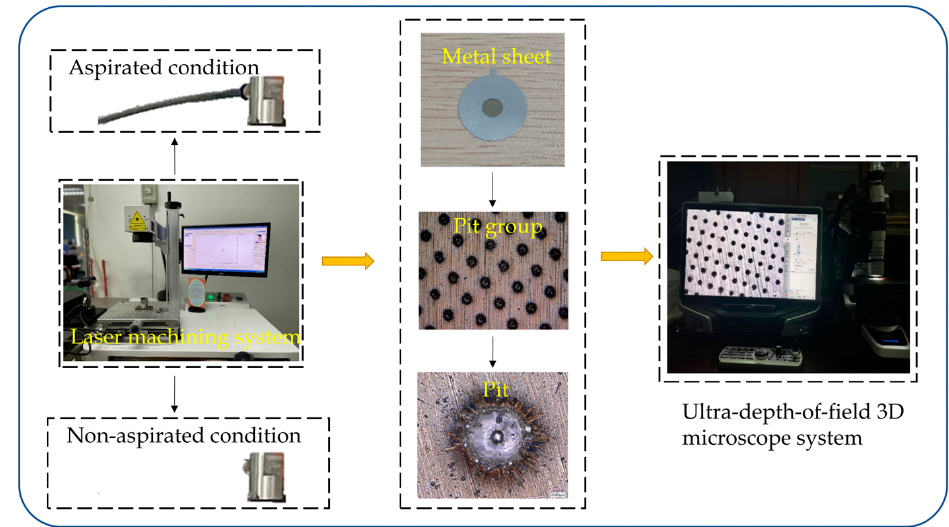
Figure 12. Experimental drawing of pit drilling and measurement.